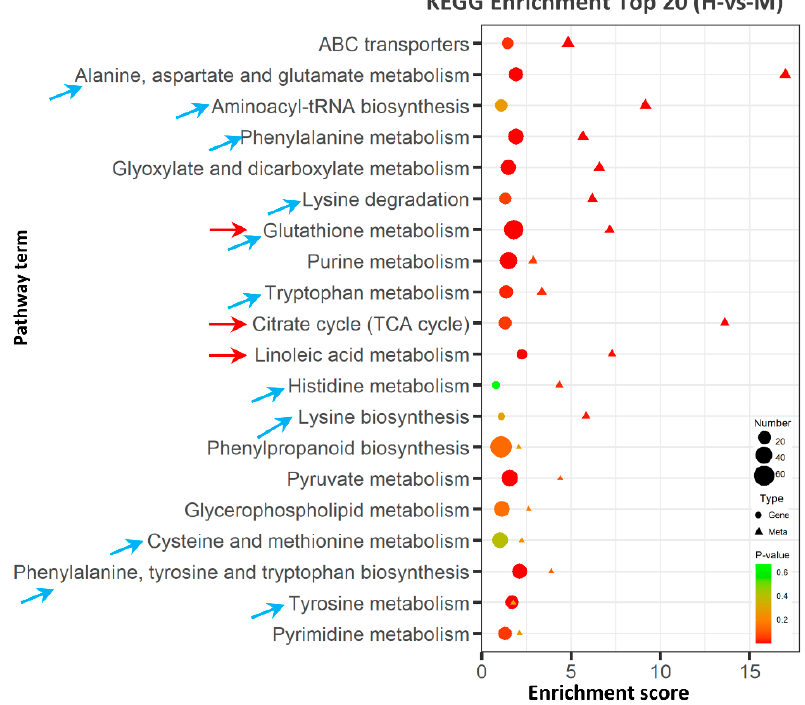
Figure 6. Integrated analysis of KEGG enrichment TOP20 of DEGs and DAMs. The X-axis indicates the enrichment score of the DEGs and DAMs. The p value is presented in a color scale, the size of the dots and triangles present DEG and DAM number mapped in each pathway, respectively. The blue arrows indicate amino acid metabolic pathways, and the red arrows indicate the pathways analyzed in detail.